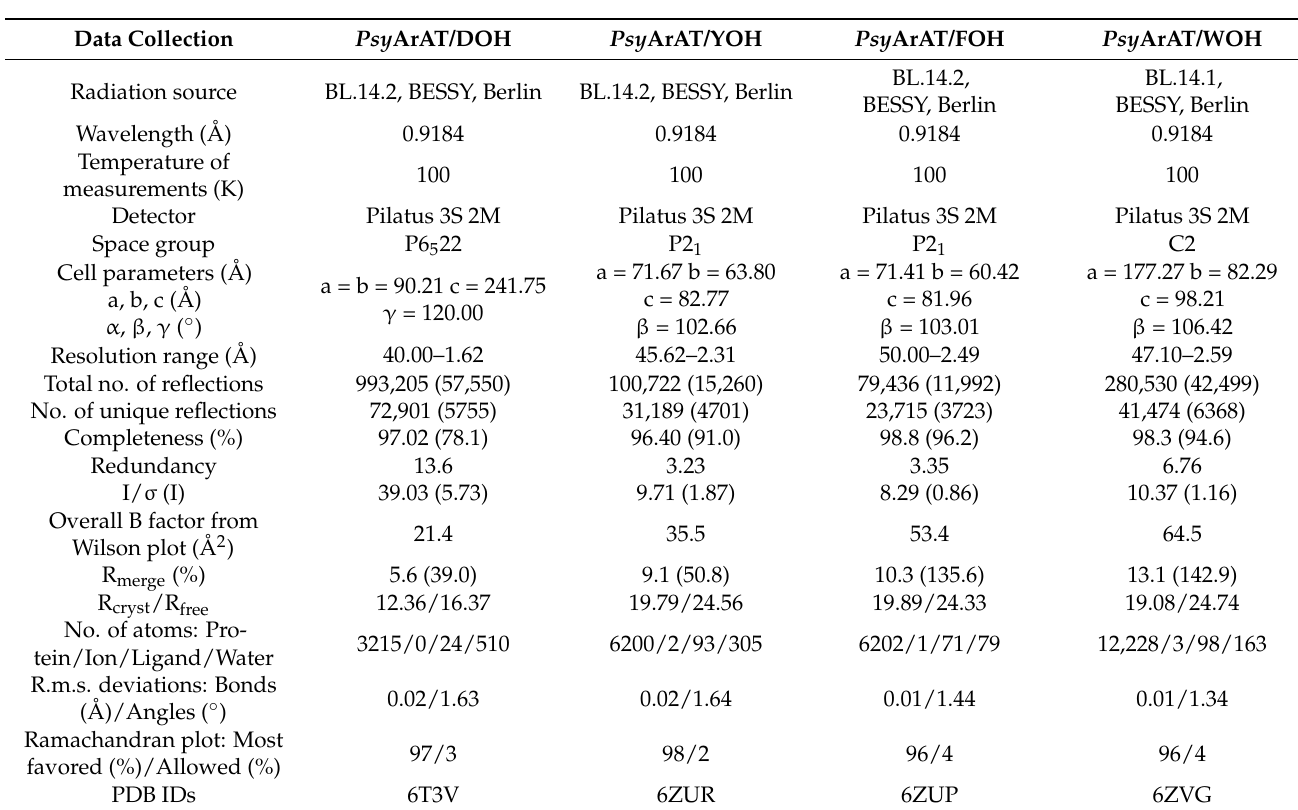
Table 1. Diffraction data collection, processing, and refinement statistics for crystal structures of Psy ArAT complexes with substrates